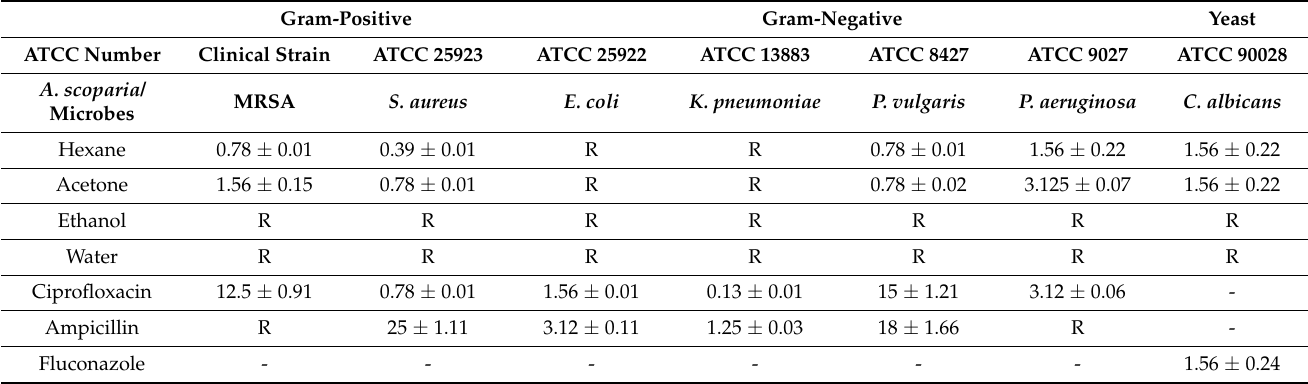
Table 2. Antimicrobial activity minimal inhibitory concentration (MIC) values ( µ g/mL) of Artemisia scoparia four extracts and antibiotics. Values are the mean ± SD of triplicate